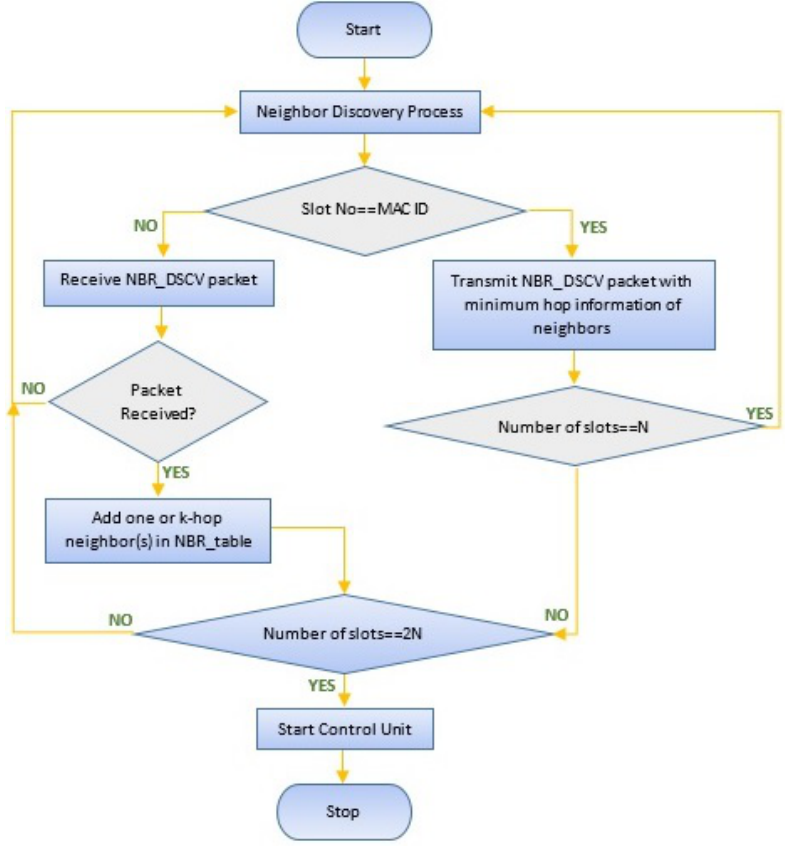
Figure 3. One-time neighbor discovery process to build the